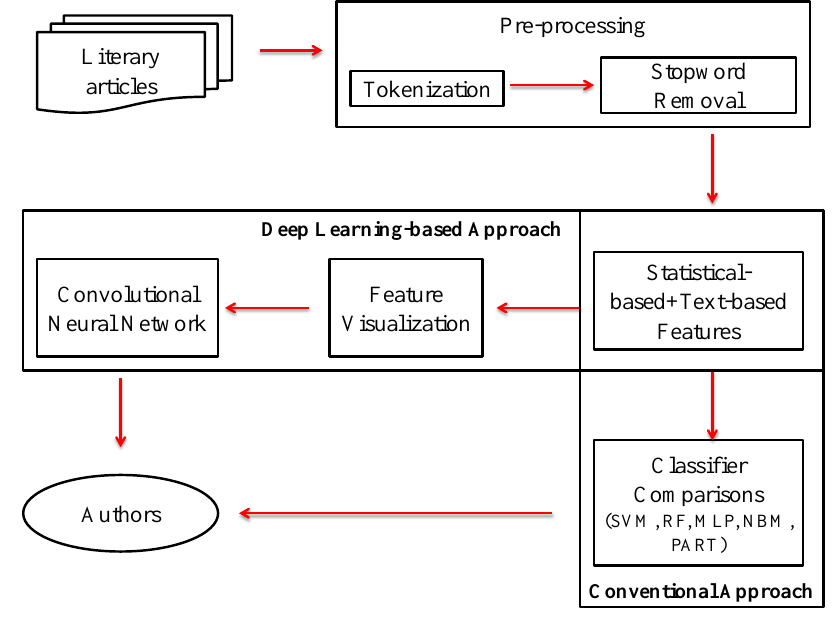
Figure 1. The methodology of the proposed